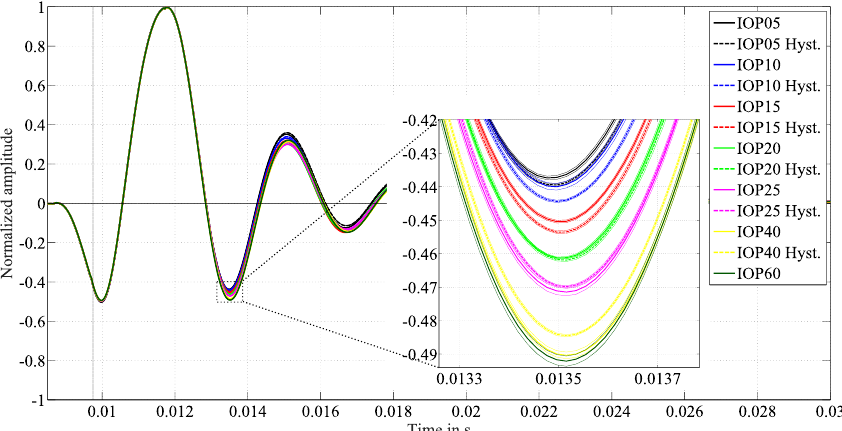
Figure 4. Diaphragm displacement detected with a Vishay CNY70 reflection sensor for porcine eye no. 3 for IOP values between 5 and 60mmHg. The dashed-line curves are recorded when the pressure was consecutively lowered, for the hysteresis test. The close-up view of the first extremal value after excitation demonstrates the IOP dependent damping behavior. The higher the adjusted IOP is, the higher the amplitude is, the lower the damping ratio is. For hysteresis tests the vitreous body was replaced by 0.9% saline solution, to avoid blocking effects of the cannula.